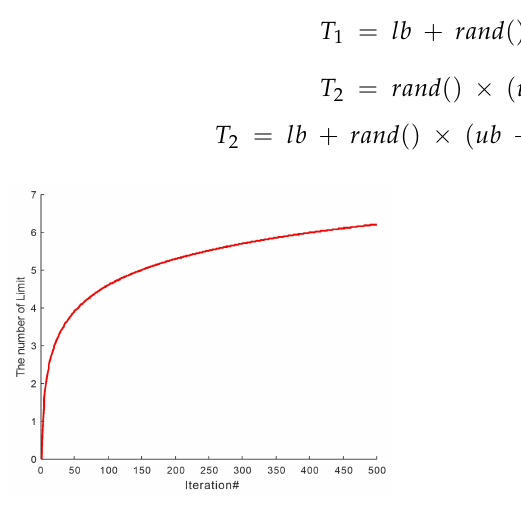
Figure 1. Limit schematic